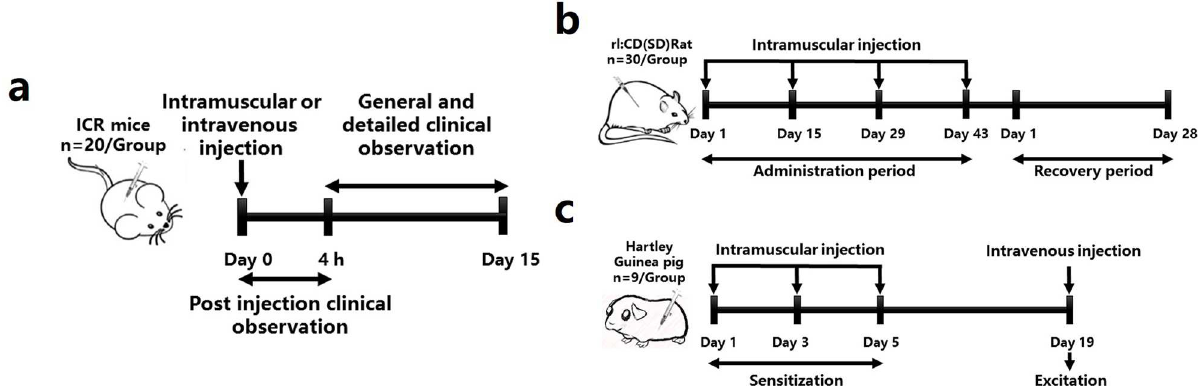
Fig 1. Procedures of safety evaluation. (a) Experimental design of GLP non-clinical acute toxic test in ICR mice. (b) Experimentaldesign of GLP non-clinicallong toxic test in rats. (c) Experimental design of GLP non-clinical allergictest in guineapigs.